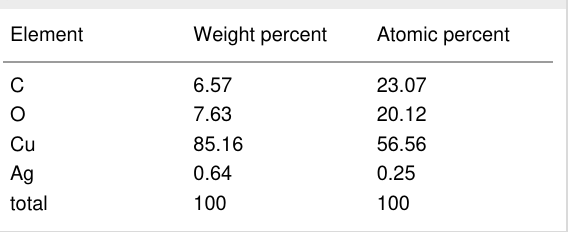
Table 2: The elemental content of the internal cavities for the hierar- chical SERS substrate with the machining feed of f x = 2 μ m and f y = 2 μ m.